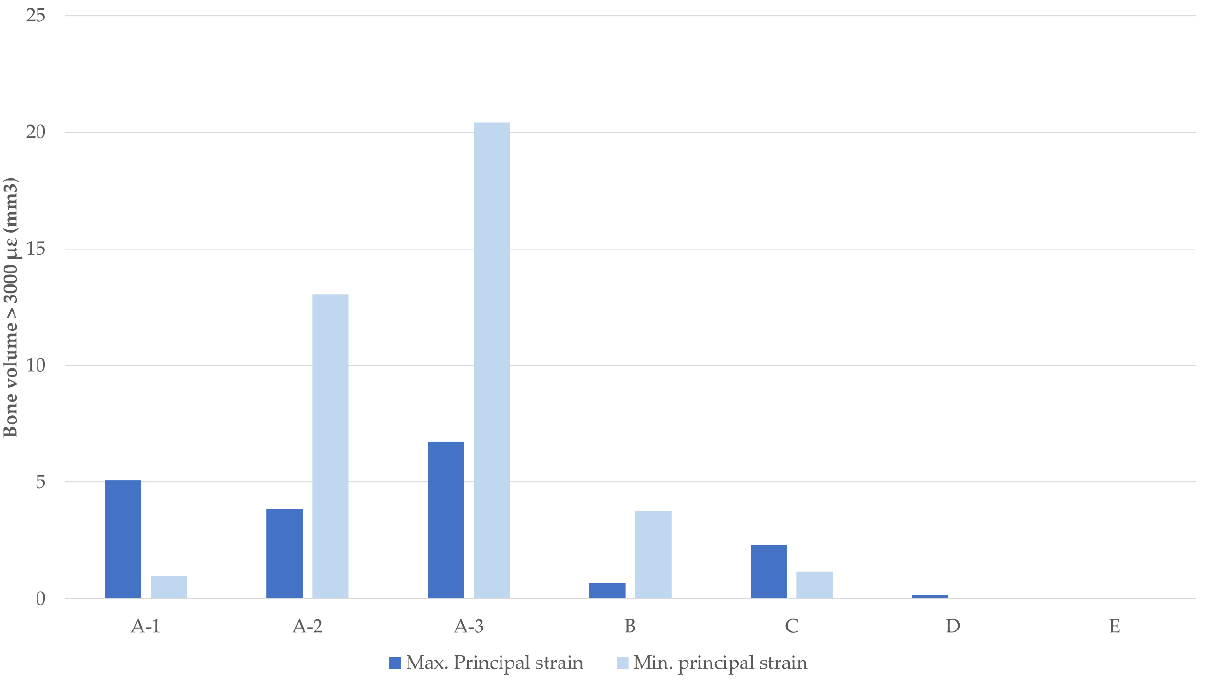
Figure 7. Region of the peri-implant bone in which the bone volume with strain > 3000 µε was calculated. The graph in Figure 8 shows the volumes of bone (mm 3 ) with a strain level above 3000 µε calculated for each simulated scenario in the region indicated above.